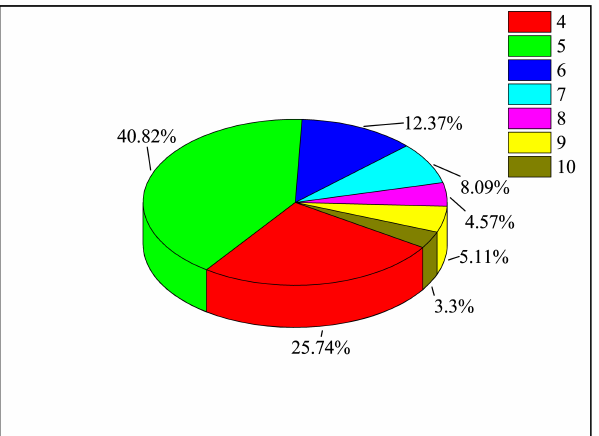
Figure 2. The proportions of nl ( n = 4 − 10) energy levels to the total cross-section in EA processes of the ground state W 45 + .